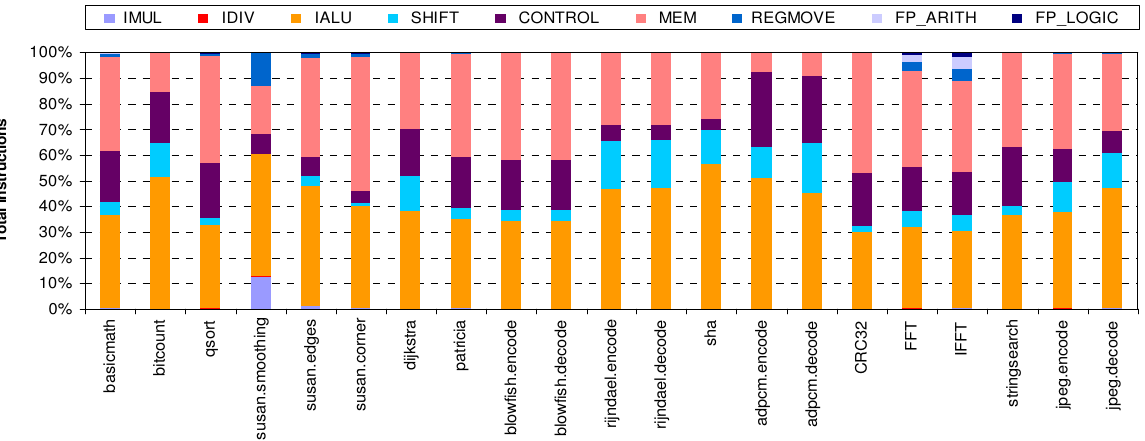
Figure 2. Instruction type distribution using the large data set per MiBench benchmark (IMUL=integer multiply, IDIV=integer division, IALU=integer ALU as listed in the text, SHIFT=logical and arithmetic shifts, CONTROL=conditional & unconditional